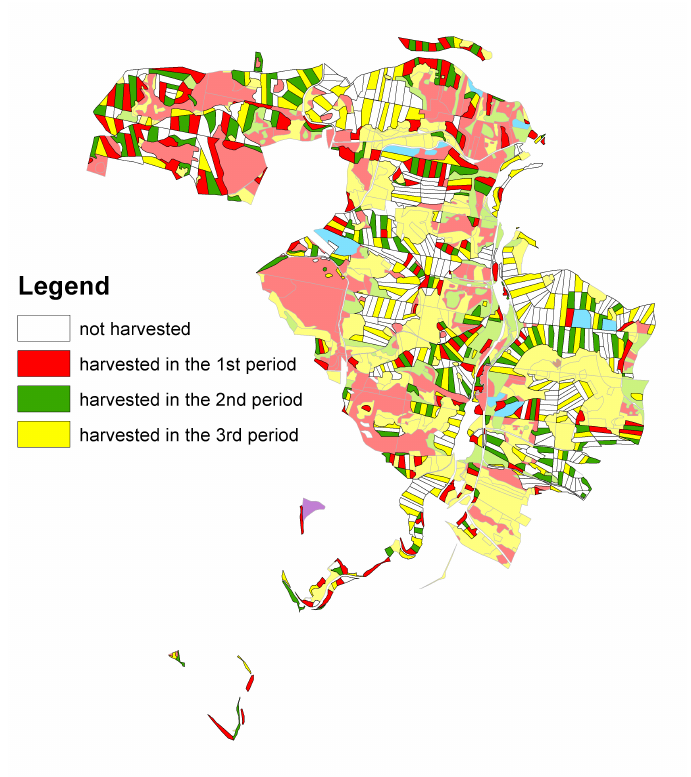
Figure 9. Graphical output of DSS (decision support systems) Optimal for ComP-M variant for 10% harvest flow difference and 1.00 × 10 −4 gap